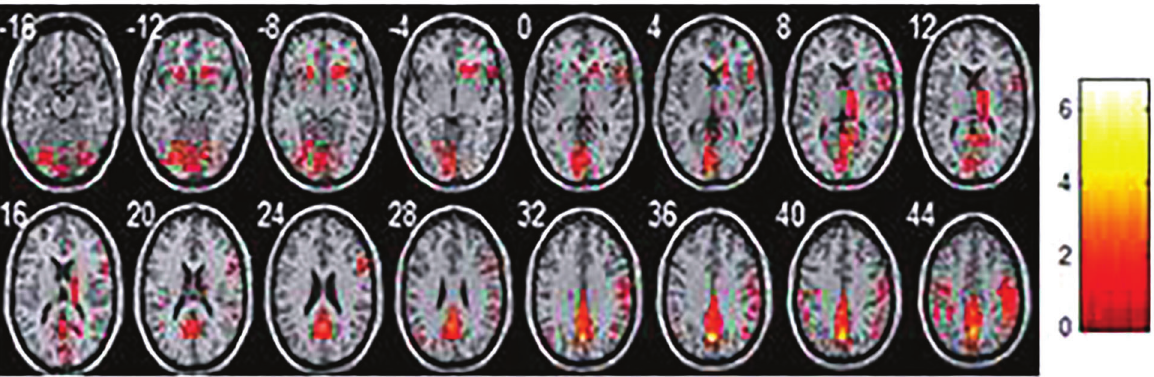
Figure 2. Average regional homogeneity in the amnestic mild cognitive impairment patients. Each image represents a slice, with 4 mm distance from the other. 0 is the 0 position of space coordinates. The color bar indicates energy